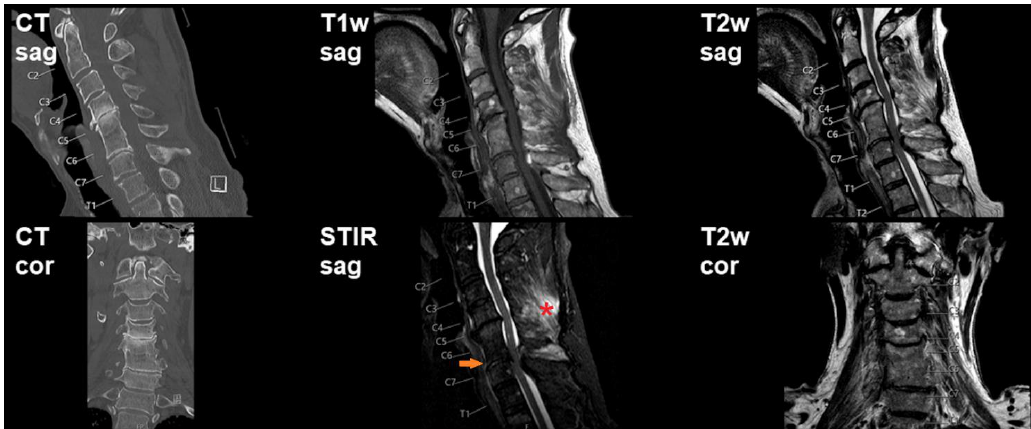
Figure 2. Preoperative imaging shows degenerative changes particularly for the segments C4/C5 and C5/C6 according to computed tomography (CT). Cervical magnetic resonance imaging (MRI), using T1-weighted, T2-weighted, and short tau inversion recovery (STIR) sequences, depicts a small prevertebral hematoma ( orange arrow in STIR imaging) as well as ligamentous injury and edema in the nuchal soft tissue ( red asterisk in STIR imaging). Furthermore, spinal stenosis is present at level C6/C7.